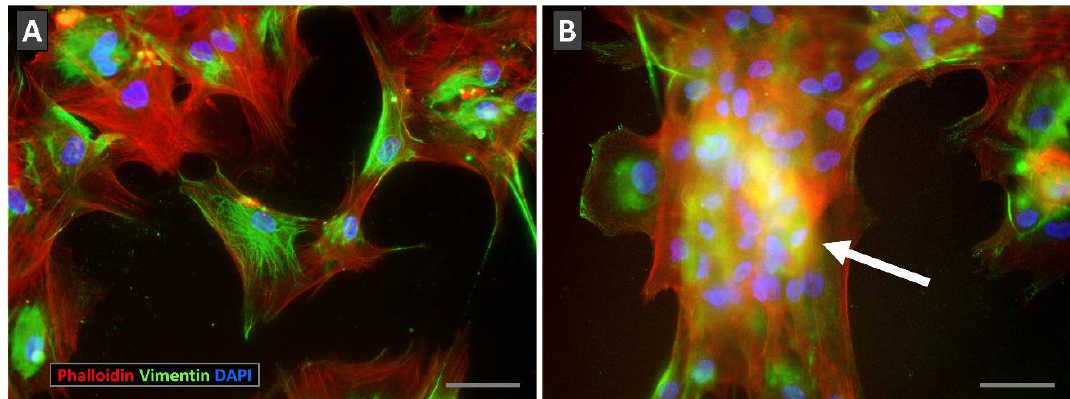
Figure 2. Effects of Eph/ephrin-Fc fusion protein treatment on the morphology of cultured BM-MSCs. ( A ) Control, Fc protein-treated MSCs attach properly to culture plates showing actin ( red ) and vimentin ( green ) filaments arranged throughout cytoplasm. ( B ) On the other hand, Eph/ephrin-Fc-treated cultures contained cellular masses with numerous nuclei ( blue ) ( arrow ) and a less expanded network of actin and vimentin filaments. Scale bars: 50 mm.